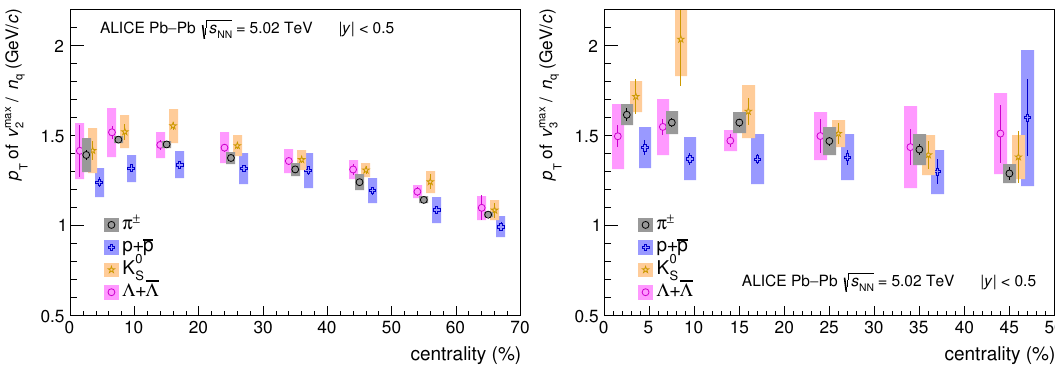
Figure 18 . (Colour online) Centrality dependence of p T j v max divided by number of constituent quarks, n q , for (cid:25) (cid:6) , p+p, (cid:3)+(cid:3), and K 0 shifted along the horizontal axis for better visibility in both panels. Statistical and systematic uncertainties are shown as bars and boxes, respectively.